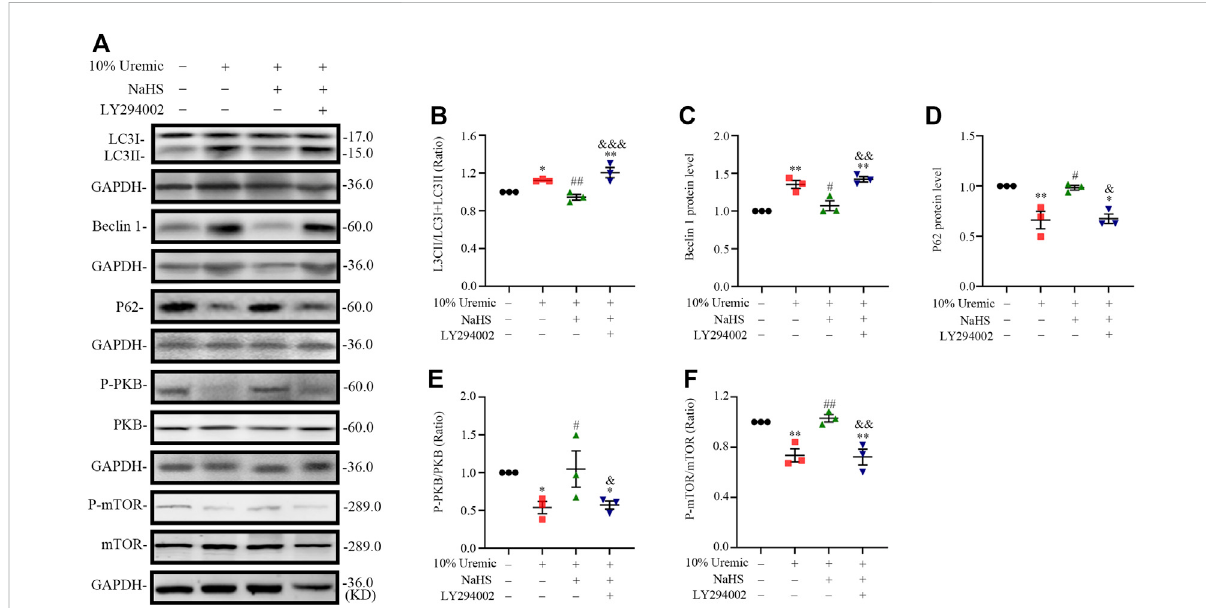
FIGURE 8 NaHSinducesPKB and mTOR phosphorylation via PI3K/PKB pathway inH9C2 cardiomyocytes stimulated by uremic serum. (A) Representative Western blot images of LC3, becline-1, P62, p-PKB/PKB and p-mTOR/mTOR in four groups of H9C2 cardiomyocytes. (B – D) Quanti fi cation of the LC3II/LC3 (I + II) ratio, becline-1 protein levels, and p62 protein levels in the four groups of H9C2 cardiomyocytes, with n = 3 per group. (E,F) Quanti fi cation of the p-PKB/PKB and p-mTOR/mTOR in four groups of H9C2 cardiomyocytes, with n = 3 per group. Data are represented as Mean ± SEM. * p < 0.05, ** p < 0.01 vs. control group; # p < 0.05, ## p < 0.01 vs. 10% serum uremia group; & p < 0.05, && p < 0.01, &&& p < 0.001 vs. 10% serum uremia + NaHS